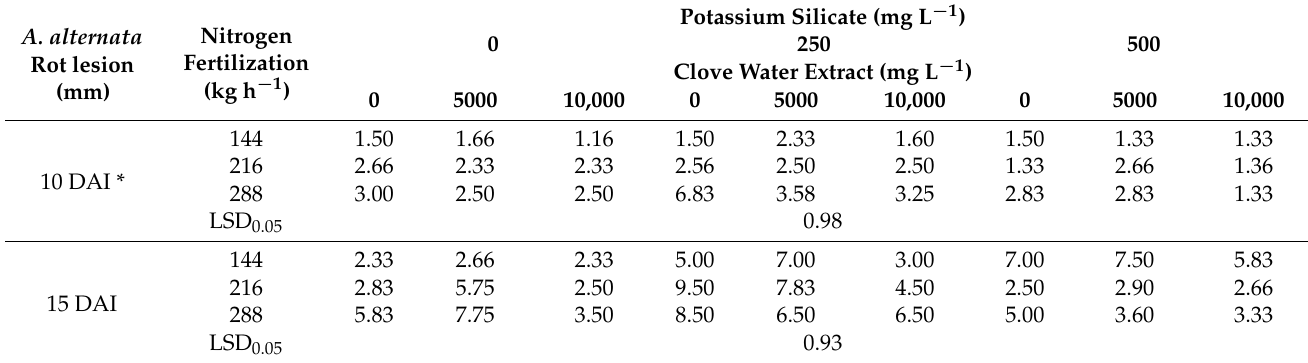
Table 7. Severity of A. alternata infection on pepper fruits as affected by the nitrogen fertilization × potassium silicate × clove water extract